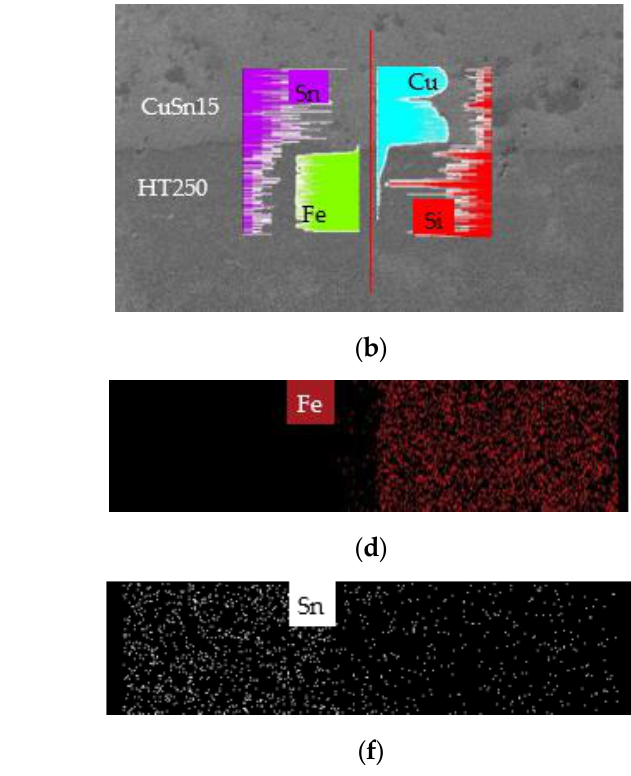
Figure 5. Element distribution in the interface between CuSn15 and HT250 obtained by EDS. ( a ) Mapping region; ( b ) line scanning region and Cu, Fe, Sn, and Si element distribution; ( c – f ) Cu, Fe, Si, and Sn element distribution in region ( a ).